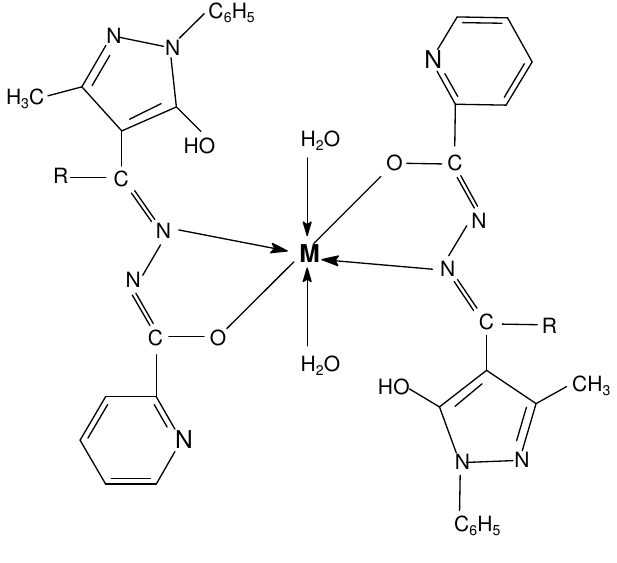
% Wt. Loss Observed Calculated